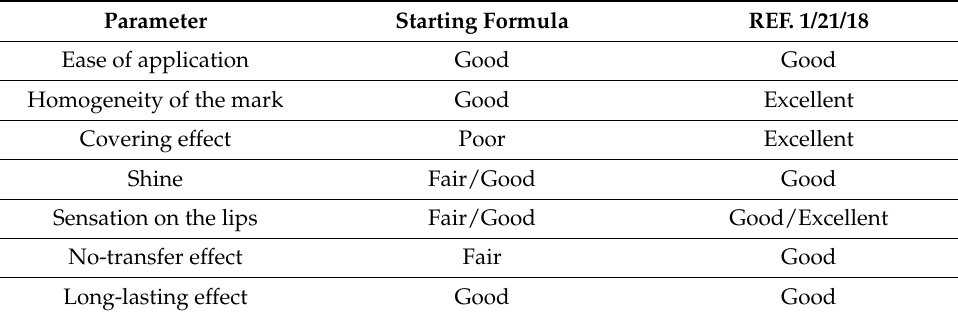
Figure 8. Initial formula vs. Ref. 1/21/18 (final formula).